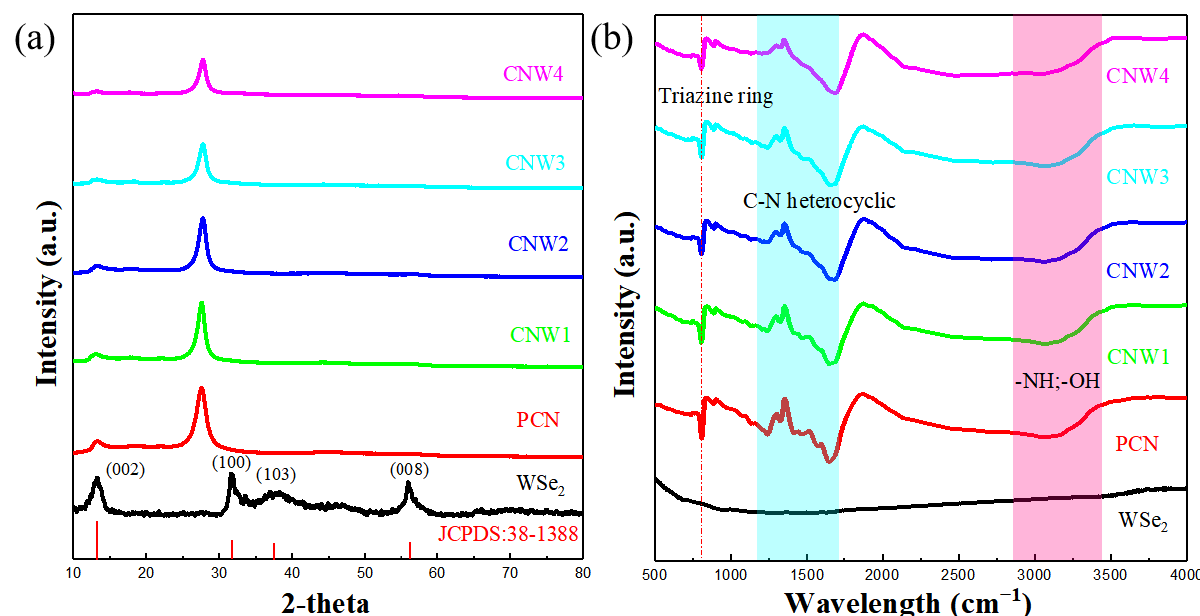
Figure 1. ( a ) XRD spectra and ( b ) FTIR spectra of pure WSe 2 , PCN, CNW1, CNW2, CNW3, and CNW4.